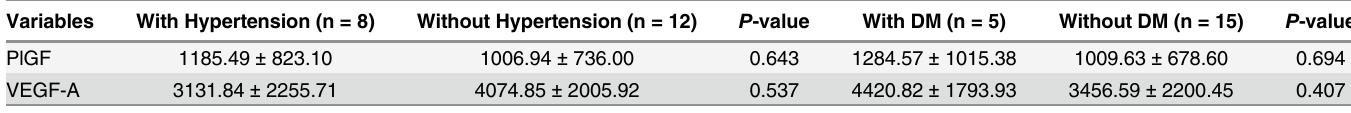
Table 5. Subgroup analysis of NVG